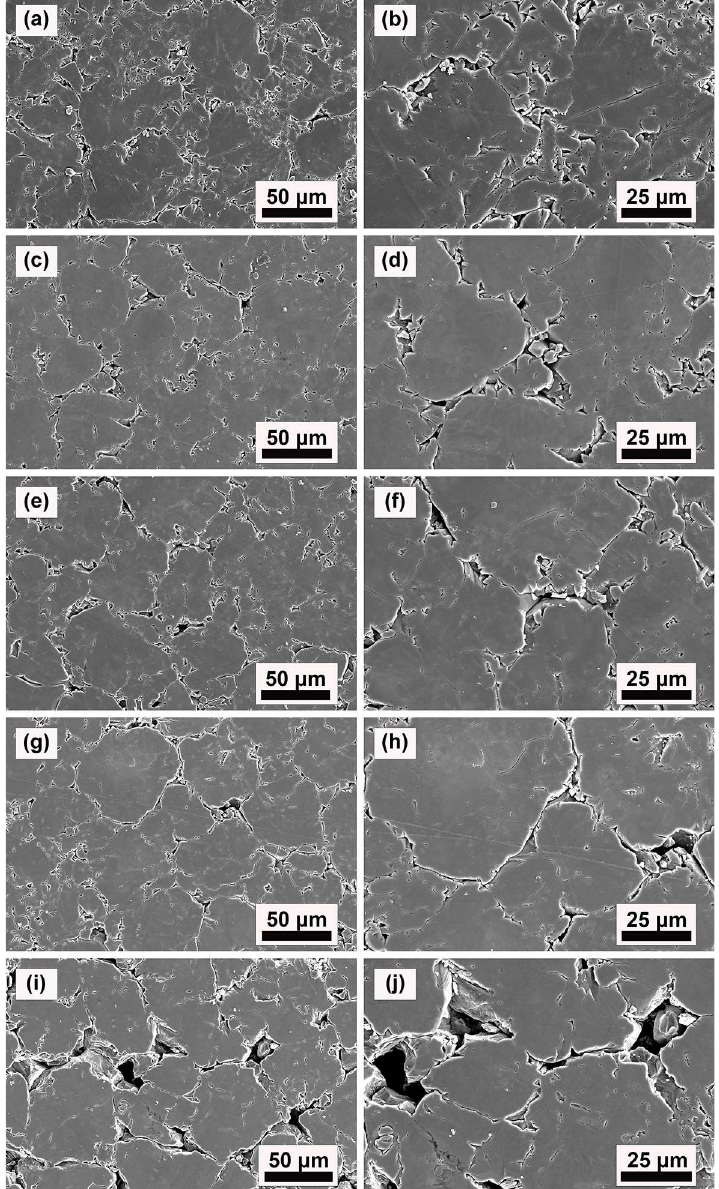
Figure 4. SEM images of the top surface of the TiH 2 ( a , b ), Dehy-1 ( c , d ), Dehy-2 ( e , f ), Dehy-3 ( g , h ) and HDH Ti ( i , j ) powders fraction-compacted at 600 MPa, showing regions of fracture, particle rearrangement and plastic deformation.